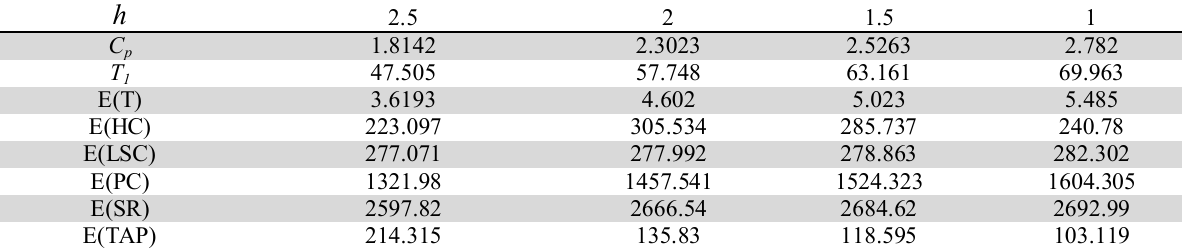
Effect of h on optimal values of